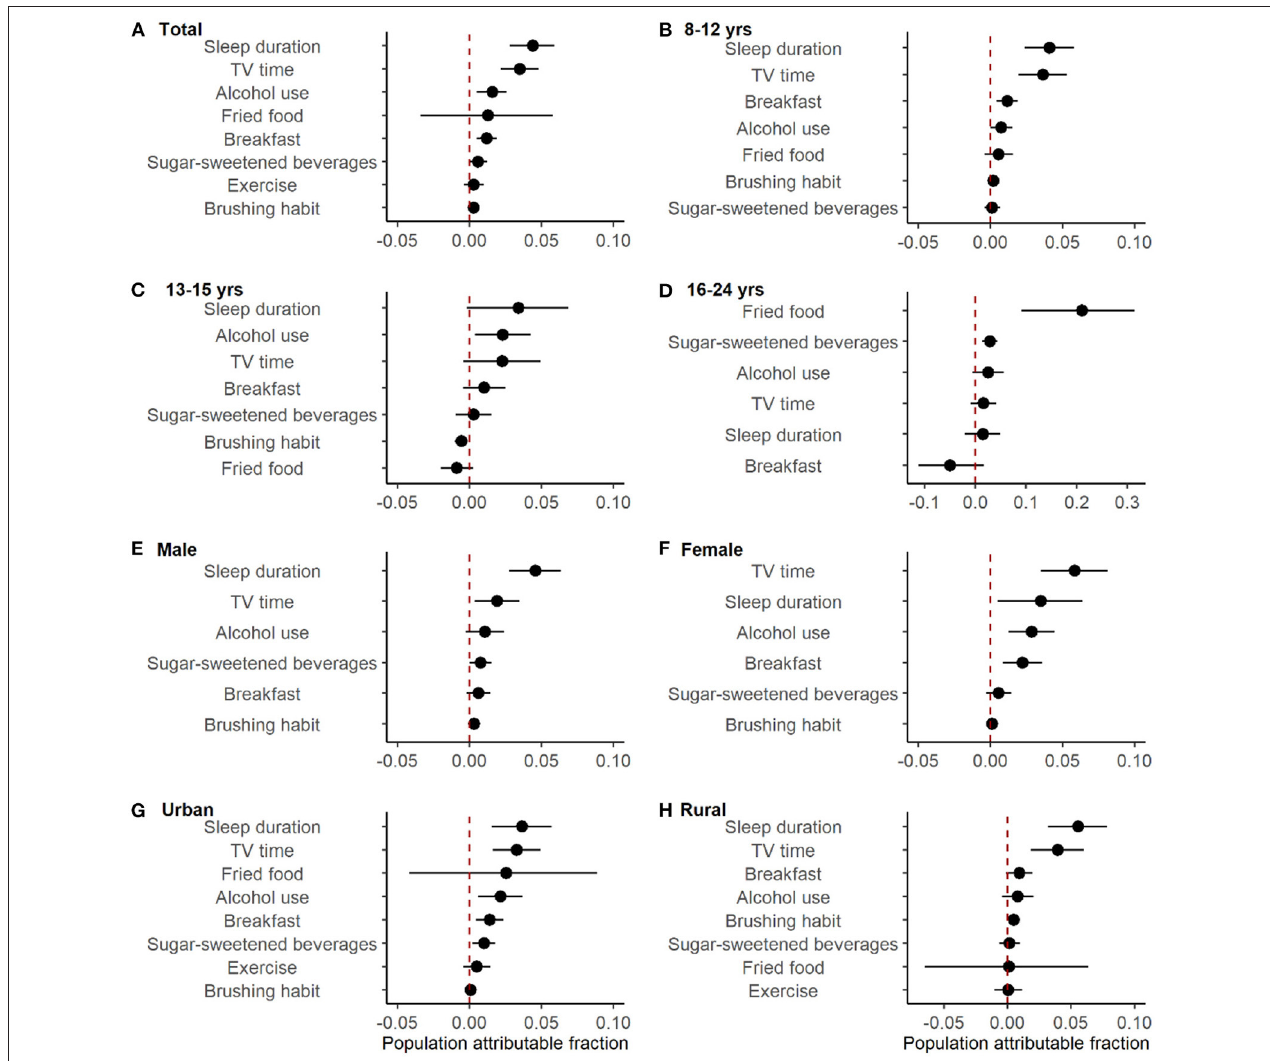
FIGURE 1 | Adjusted population attributable fractions of lifestyle factors for overweight/obesity. Models were adjusted for age, sex, city, urban/rural area and all other factors. Dots were the estimated values. Error bars were 95% confidence intervals. (B, C) exercise wasn’t shown because it was insignificant and had too wide CI to be shown. (D) toothbrushing habit wasn’t shown because it was insignificant and the number of people who occasionally or didn’t brush their teeth every day was small (54/11205). (E, F) fired food and exercise weren’t shown because they were insignificant and had too wide CI to be